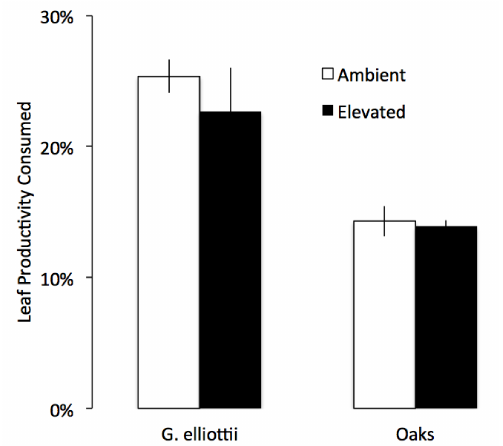
Figure 6. Percent of leaf productivity consumed by herbivores for the N 2 -fixing vine, G. elliottii , and for the three co-dominant oak species in the ambient- and elevated-CO 2 -treated plots.